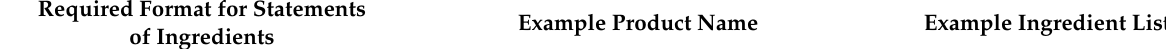
Table A1. Formatting requirements for successful disaggregation of a statement of